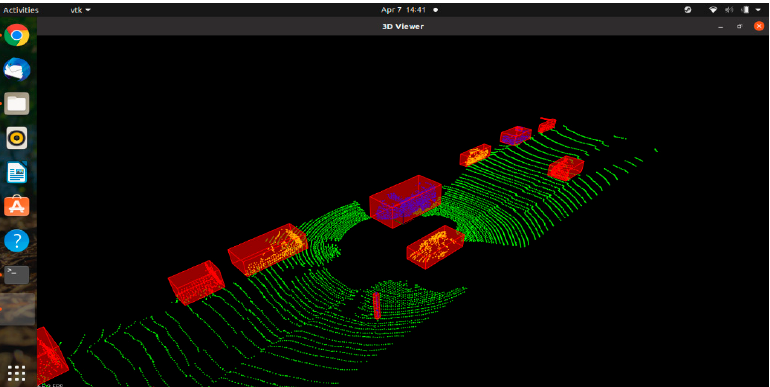
Figure 7. Bounding boxes drawn around the high-density clusters in LiDAR point cloud using DBSCAN.